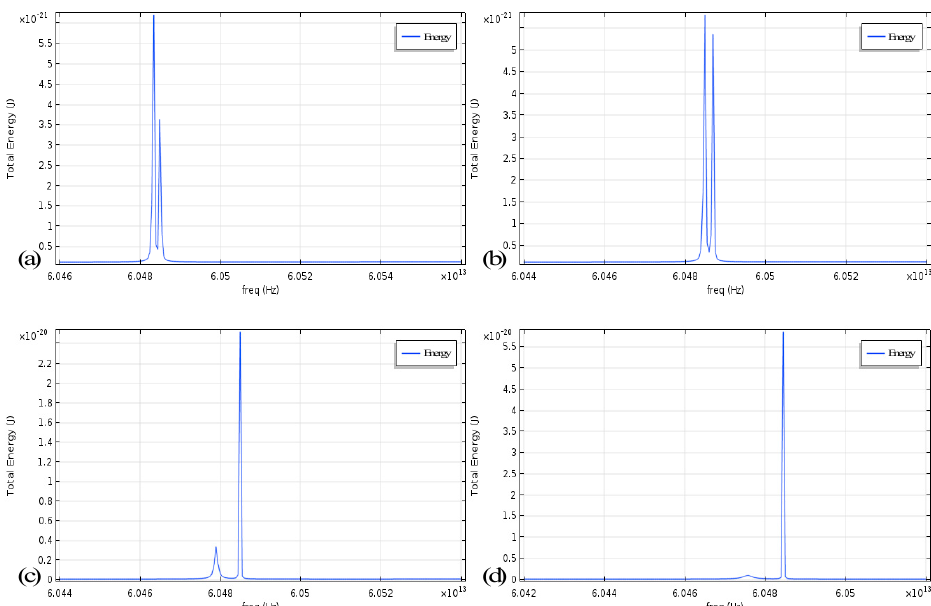
Figure 2. Light distribution of symmetric mode (SM) and asymmetric mode (ASM) in the cavity with mode splitting induced by different scattering: ( a , c ) Diameter 0.1 μ m and 0.2 μ m, tangent to the cavity; ( b , d ) Diameter 0.1 μ m and 0.2 μ m with a position of 0.05 μ m further from the cavity than ( a , c ).